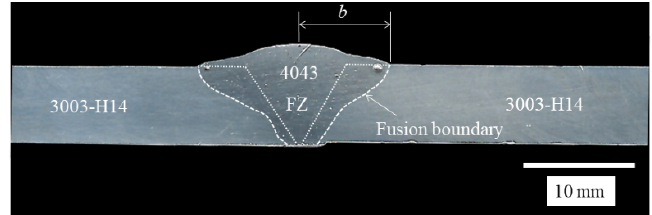
Figure 7. Welding profile obtained for the 3003-H14 welded plates.